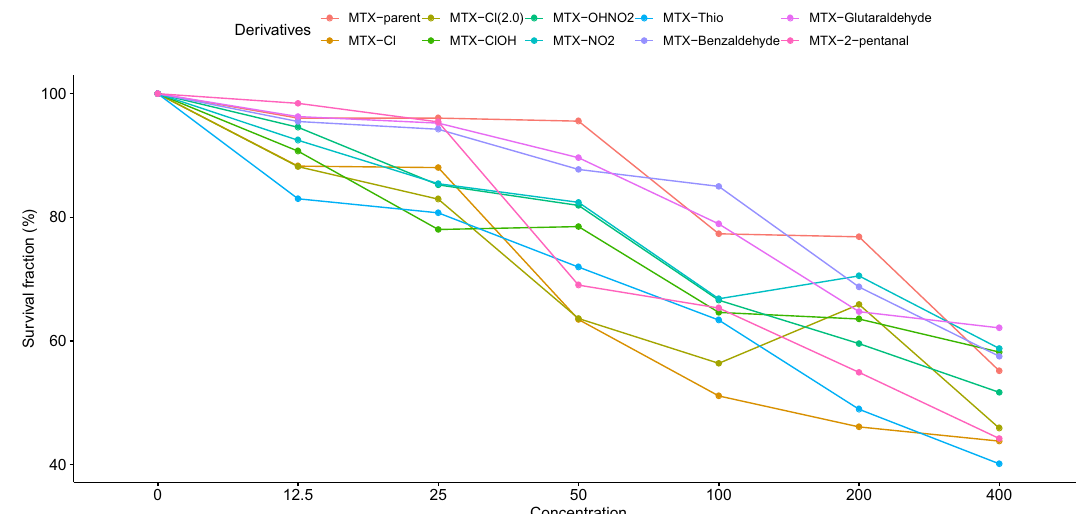
Figure 1. At various concentrations, the survival fraction of these MTX derivatives against human malignant glioma U87 (MG-U87) cell lines is